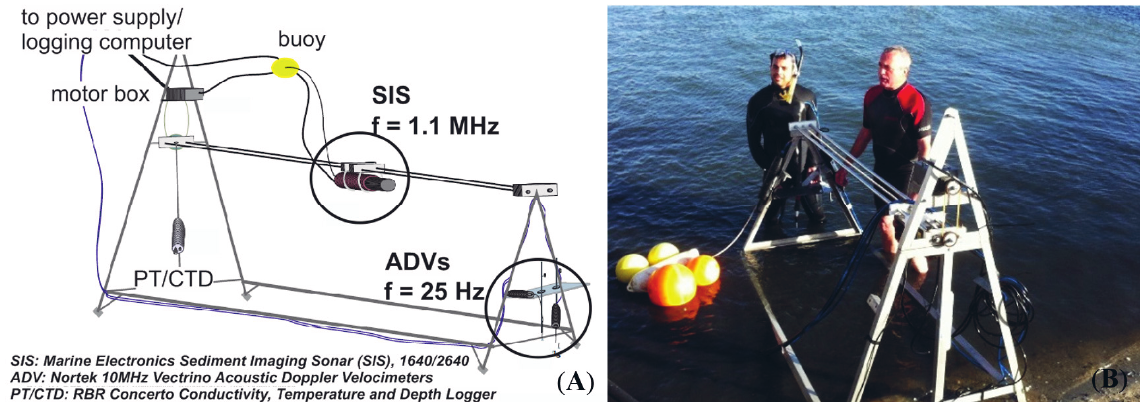
Figure 4. ( A ) A schematic of the BRAD device (modified from Lefebvre [11]); ( B ) The BRAD device on